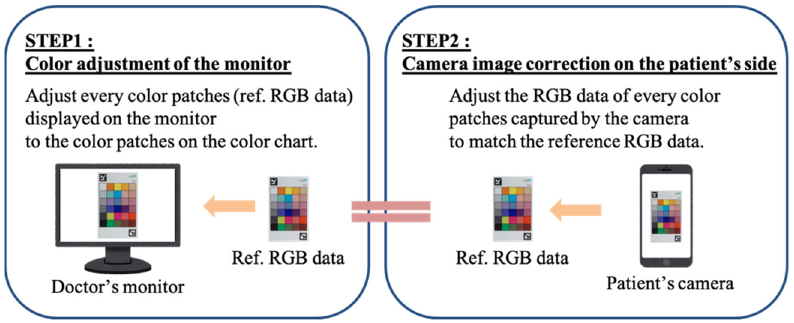
Figure 1. Overview of the automatic color correction method.